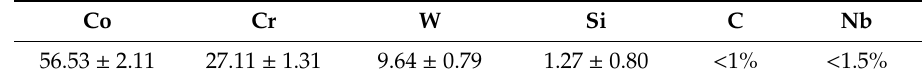
Table 1. Chemical composition of CoCr alloy.